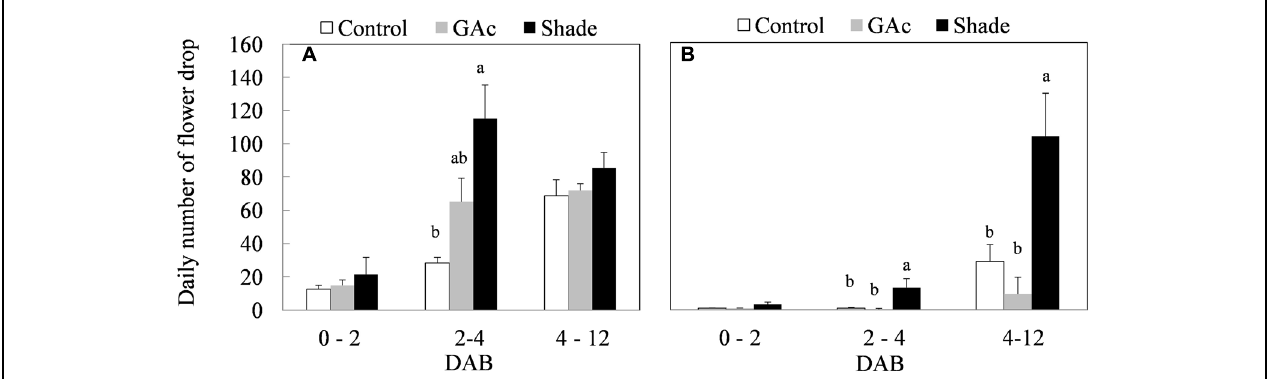
FIGURE 2 | Average daily number of flower drop in summer (A) and spring (B) production cycles as effect of GAc and shade treatments on ‘Black Magic’ vines (mean ± SE). Within each sampling date, different letters indicate statistically significant differences ( P < 0.05).